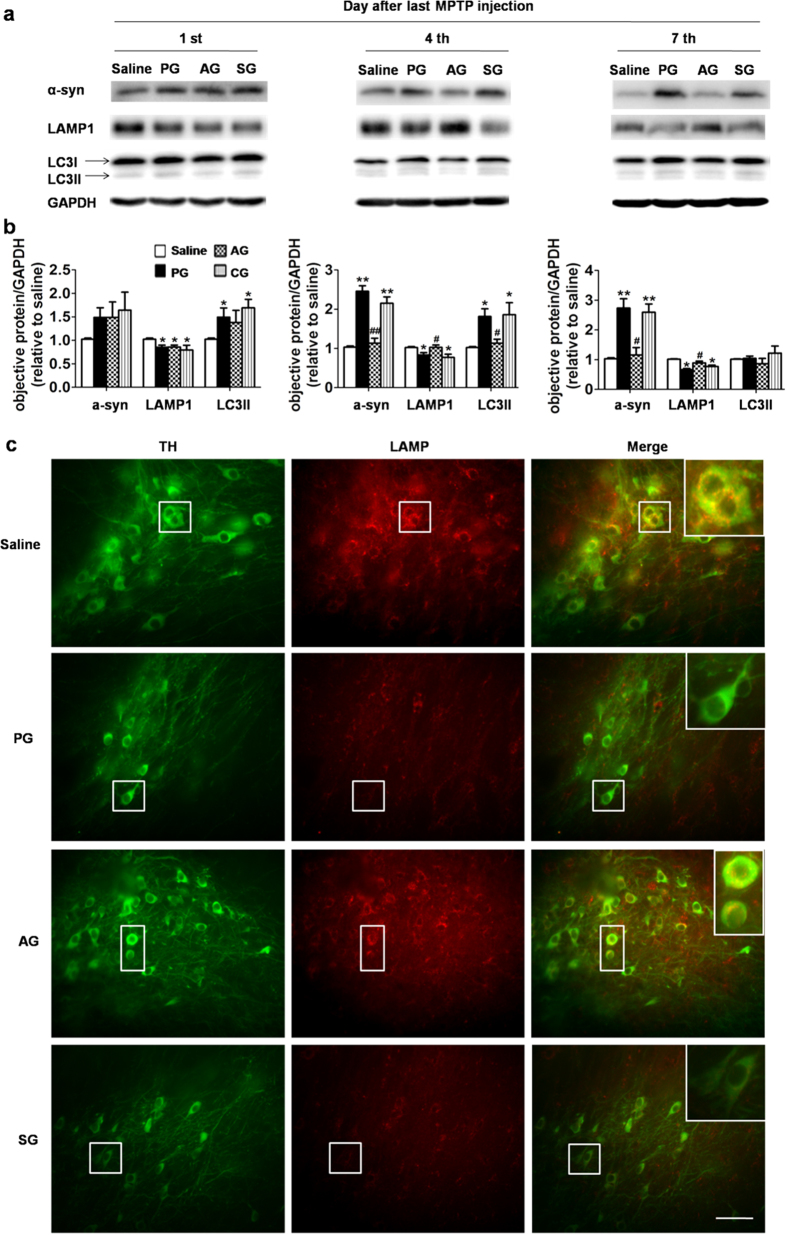
Acupuncture treatment at GB34 regulates the expression of α-syn and the autophagy-lysosome pathway in the substantia nigra of PD mice.(a) Immunoblot levels of α-syn, LAMP1 and LC3II in the mouse SNpc in AG for different days (1st, 4th, 7th day after last MPTP injection). (b) the optical density of α-syn, LAMP1 and LC3II in SNpc. In all panels, *P < 0.05, **P < 0.01 compared with SG. #P < 0.05, ##P < 0.01 compared with PG. n = 8 per experimental group. (c) The fluorescent images for TH (green) and LAMP2 (red) in SNpc of each group. n = 4–5 per experimental group. Scale bar: 100 μm.